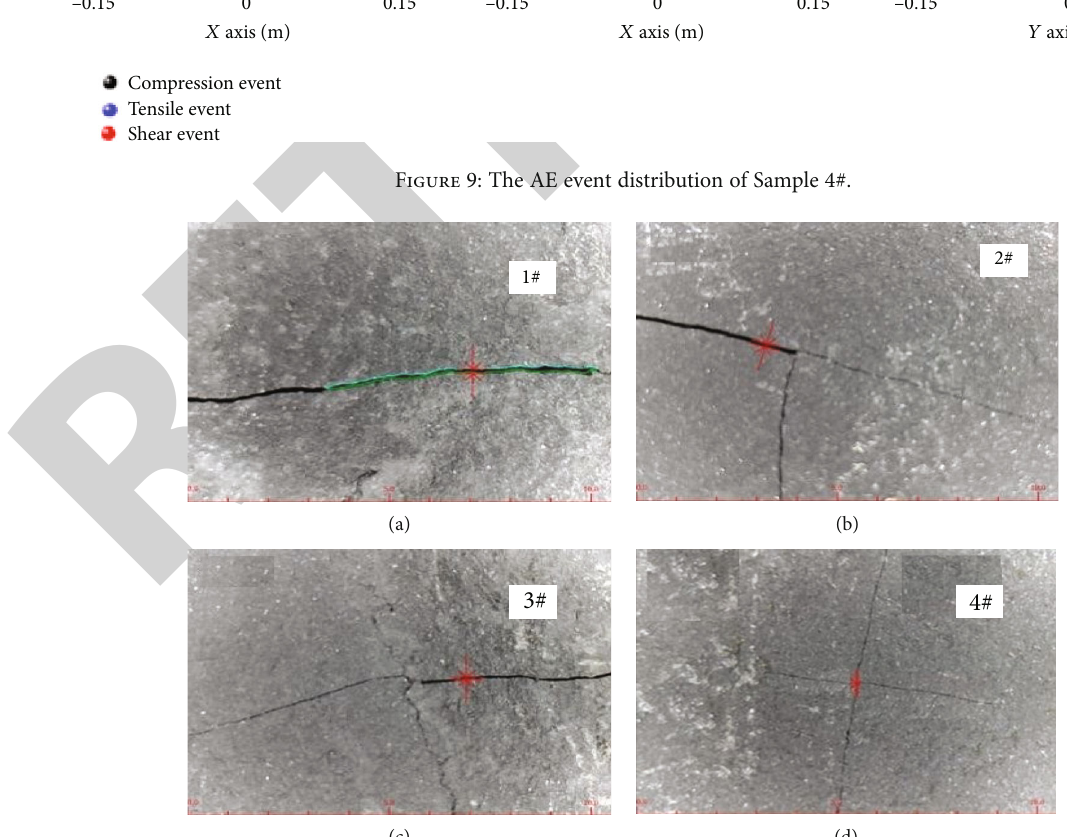
Figure 9: The AE event distribution of Sample 4#.